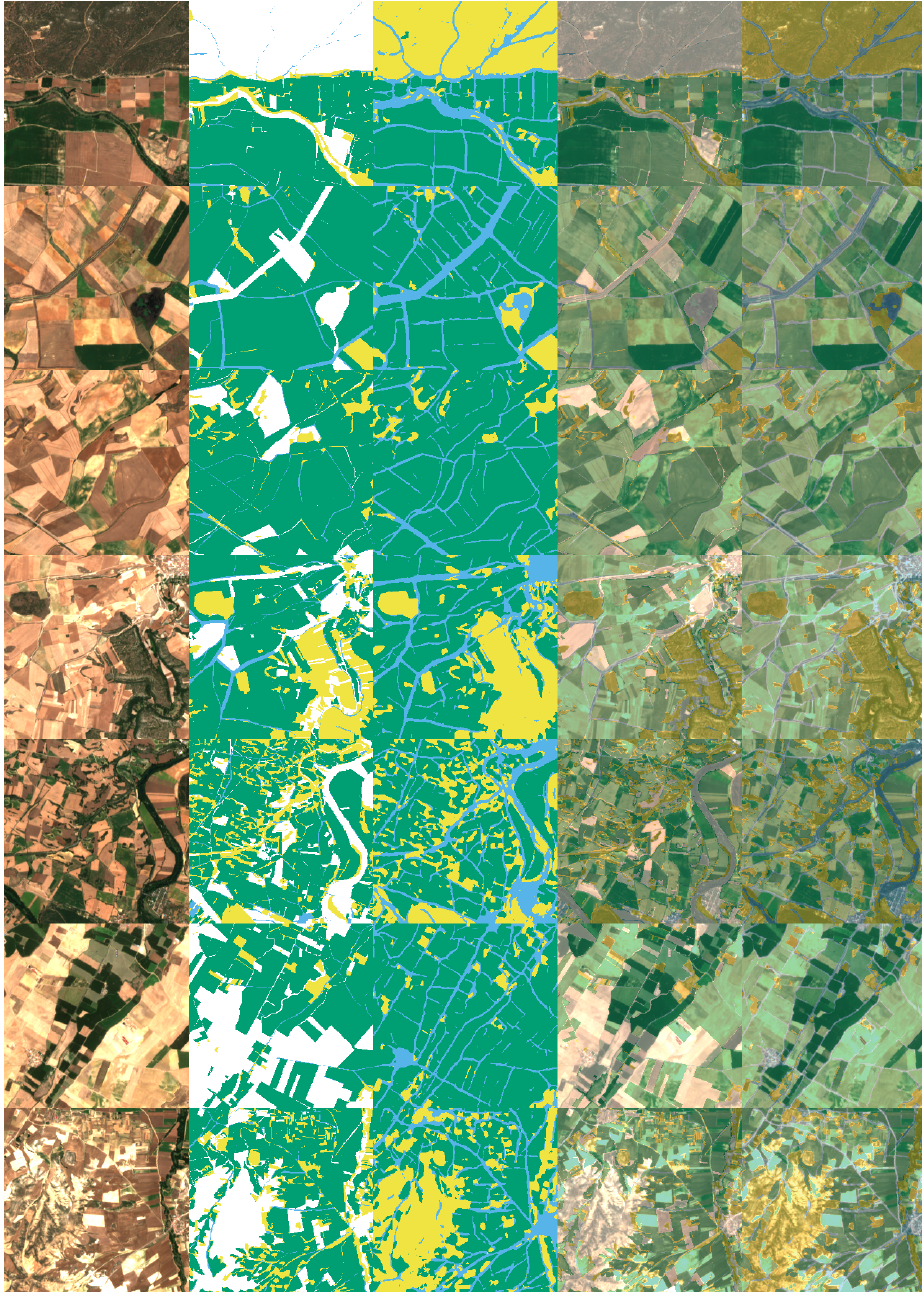
Figure 17. Visualization of the predicted results for UNet evaluated in UOS2 for four classes (Experiment Base). ( 1st col. ) Original images, ( 2nd col. ) ground truth masks, ( 3rd col. ) predictions, ( 4th col. ) overlapping of original images with ground truth masks, ( 5th col. ) overlapping of original images with